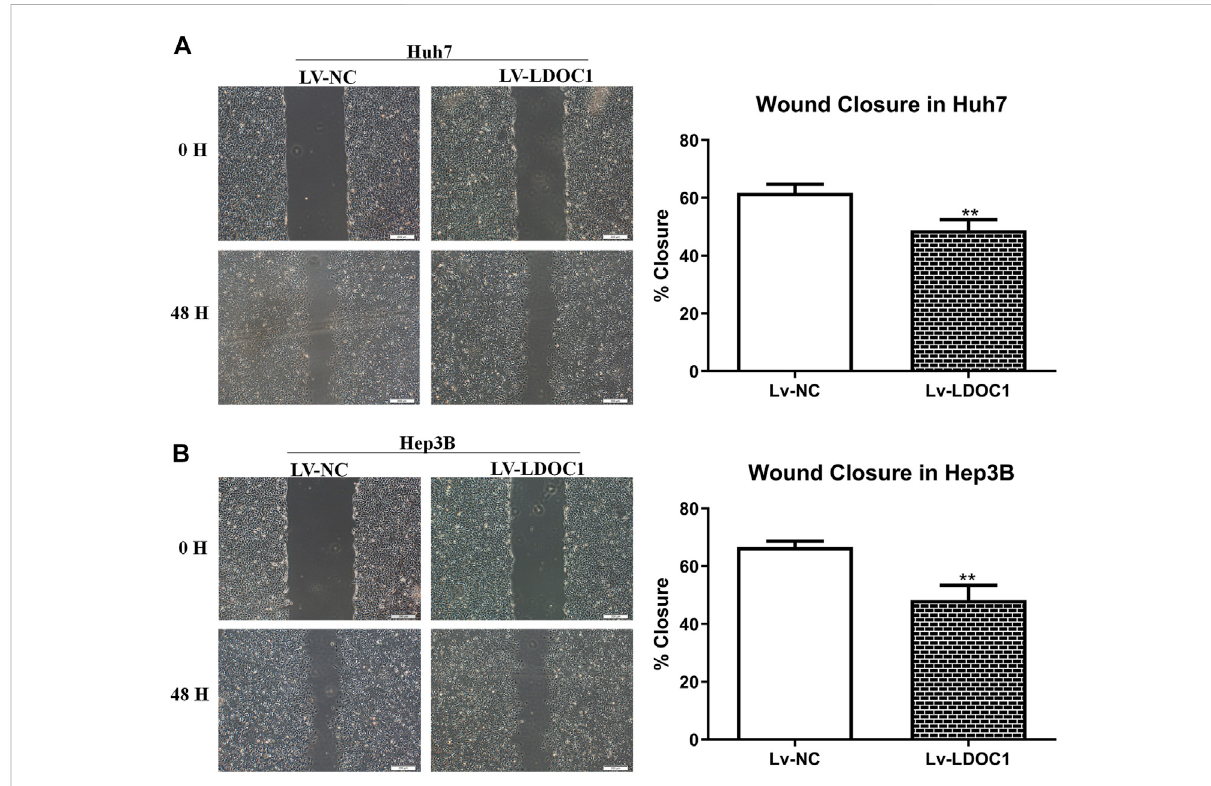
FIGURE 8 Migration ability assays for Huh7 (A) and Hep3B (B) cell lines after LDOC1 overexpressing. **, p <